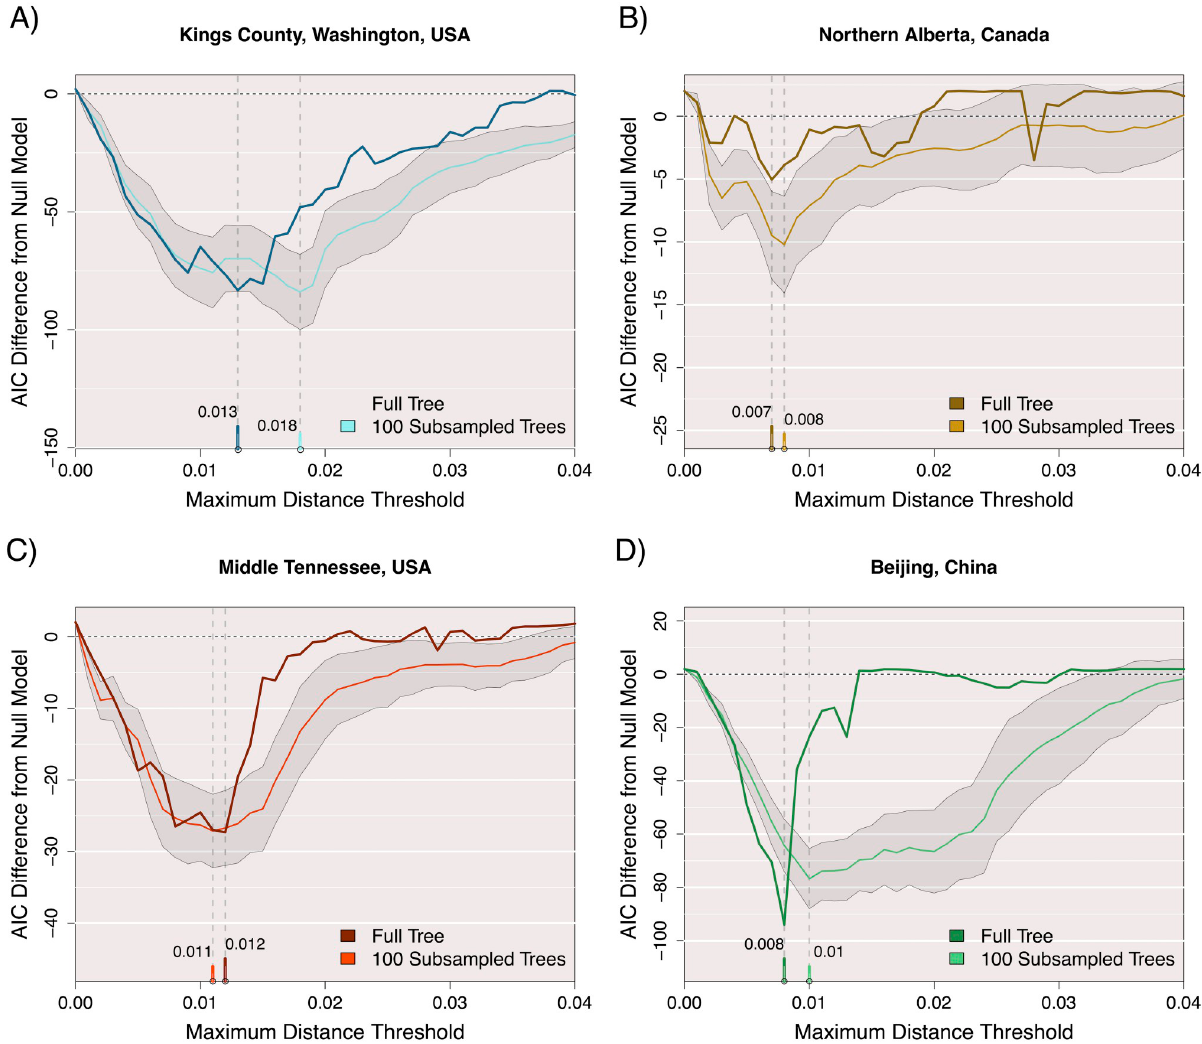
Fig 3. Difference in AIC between Poisson-linked models of cluster growth. Clusters and growth are defined at 41 different maximum distance thresholds from 0 to 0.04 with a minimum bootstrap support requirement of 95% for ancestral nodes. The AIC of a null model where size predicts growth is subtracted from the AIC of a proposed model where size and mean time predict growth. The darker colour in each plot corresponds to these AIC results for a maxmimum likelihood tree built from the full set of old sequences, while the lighter colour represents the mean AIC difference obtained by this threshold for 100 approximate likelihood trees built on 80% subsamples of the old sequences without replacement. The shaded area represents 1 standard deviation from the mean AIC difference for subsamples at this threshold. Date of sequence collection was used to measure time for all data